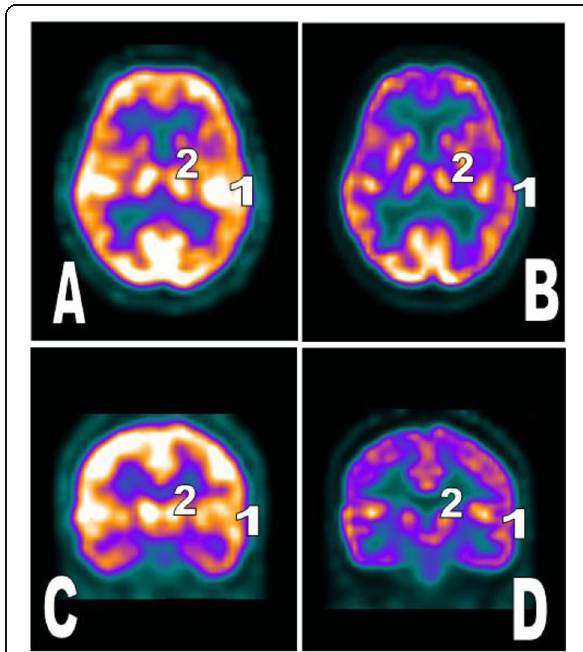
Fig. 1 Seventy-one-year-old female discovered to have colon cancer by prior CT, the patient came for PET/CT assessment. Fused coronal and axial PET/CT images show reduced FDG uptake in the post chemotherapeutic state (images b and d ) compared to the pre- chemotherapeutic state (images a and c ) along the left temporal lobes {1} (SUVmean 29 compared to 8.5) and the left basal ganglia {2} (SUVmean 25 compared to 6.5)